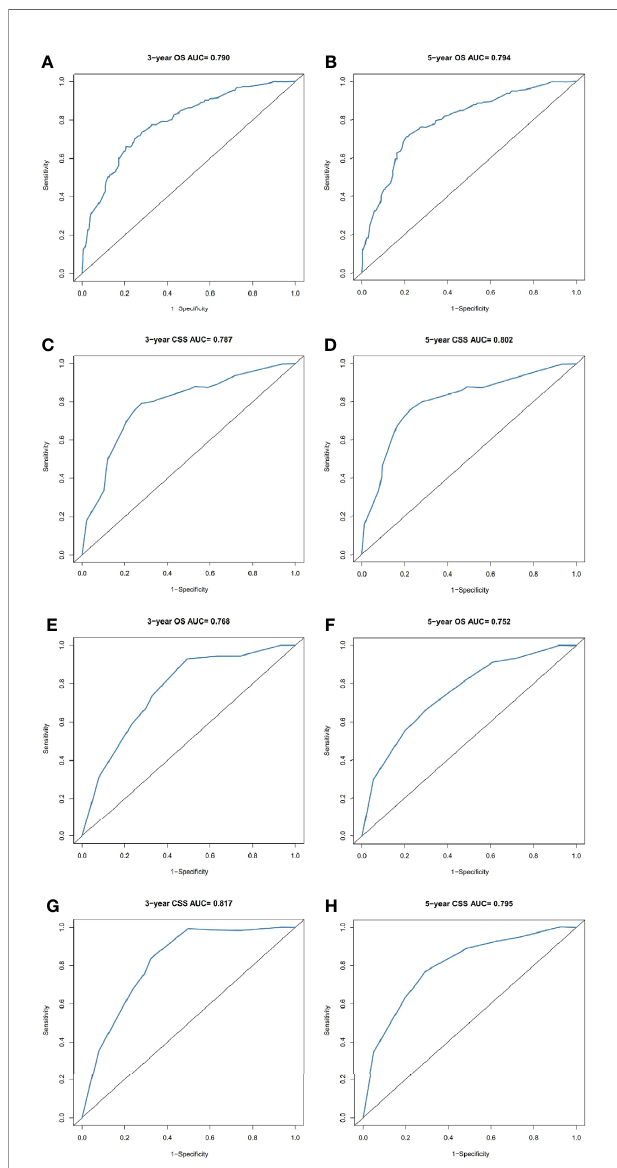
FIGURE 7 | Comparison of the ROC curves of the nomograms for 3- and 5-year OS and CSS prediction of the training cohort (A – D) and validation cohort (E – H)